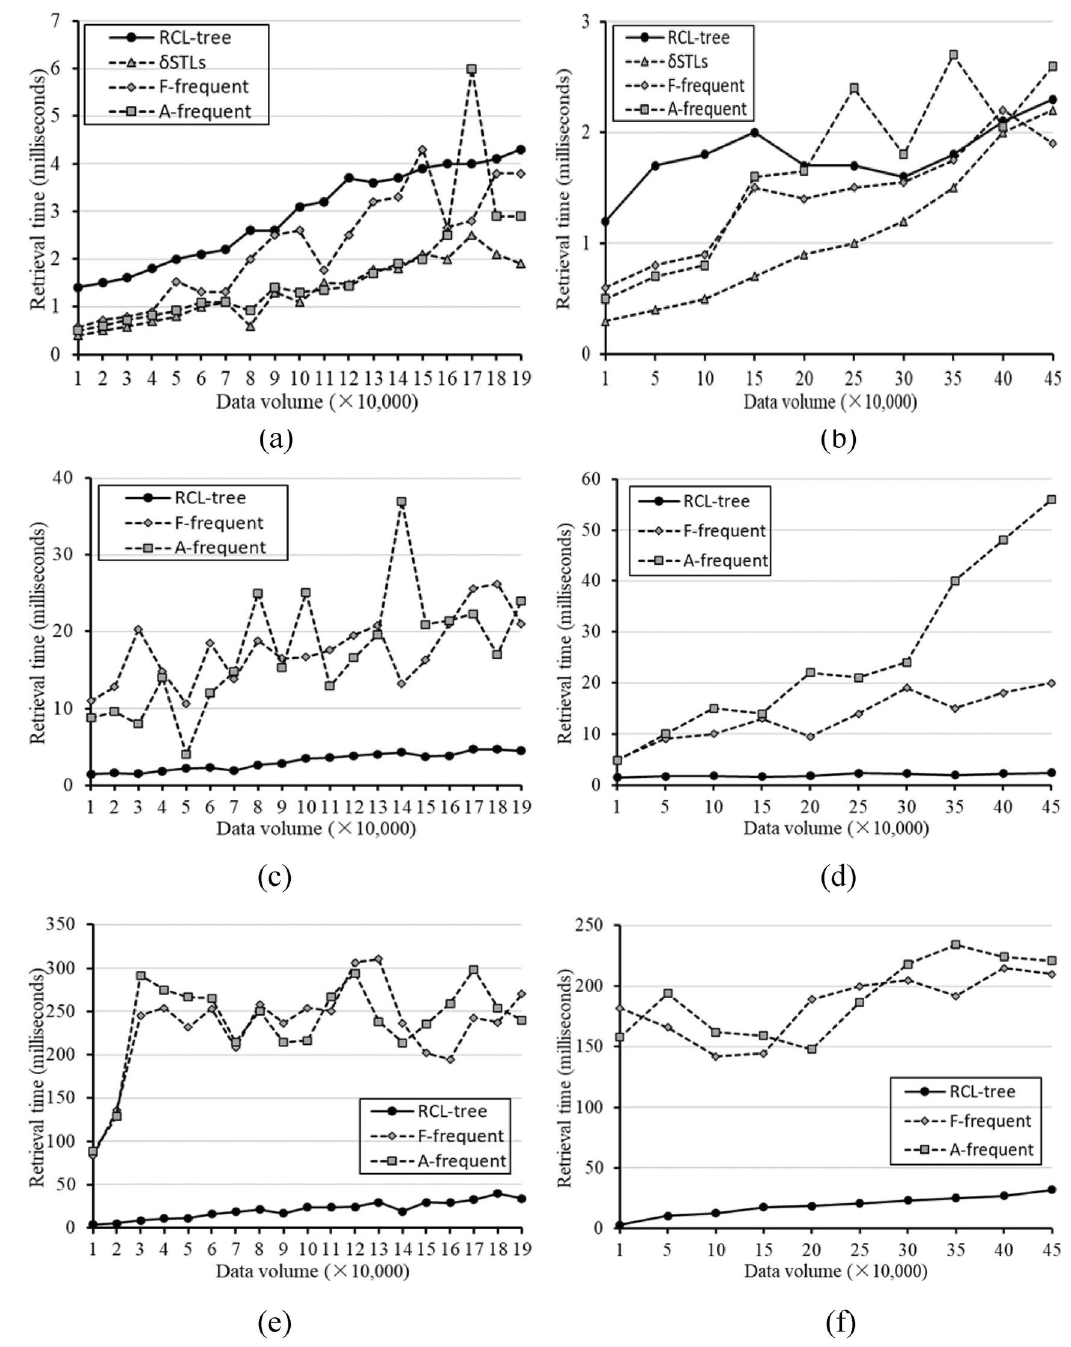
Figure 7. Effect of data volume and the number of query keywords on retrieval time. ( a ) I Yelp with K . size = 0 , ( b ) I Amap with K . size = 0 , ( c ) I Yelp with K . size = 1 , ( d ) I Amap with K . size = 1 , ( e ) I Yelp with K . size = 2 , ( f ) I Amap with K . size = 2